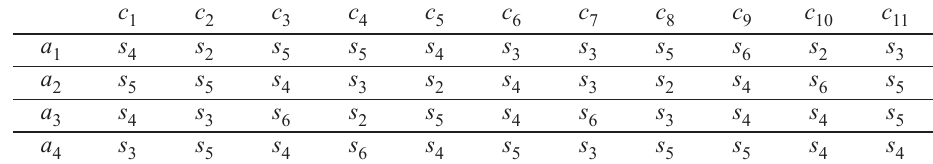
Table 3. The evaluation value of different attribute in different